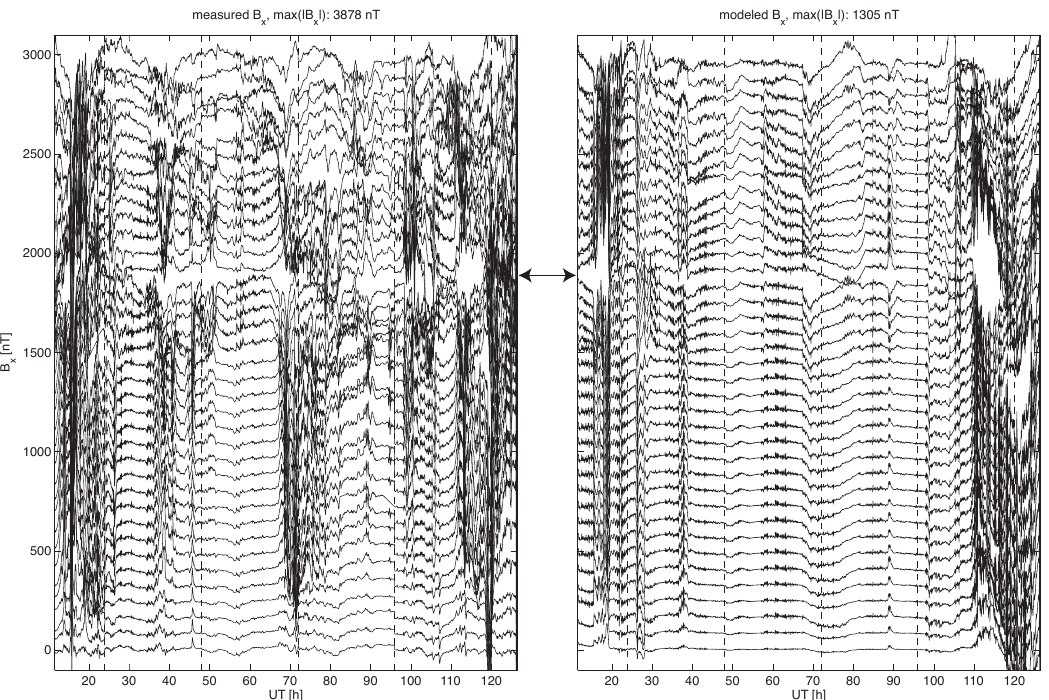
Fig. 4. The x-component (geographic north) of the measured (left panel) and the modeled (right panel) magnetic field fluctuations at stations shown in Fig. 3. Arrow in between the panels shows the separation between stations west of the Greenwich meridian (up from the arrow) and east of the Greenwich meridian (down from the arrow). Both sets are arranged from the geographically southernmost (bottom) to the northernmost (top) station. The time is UT hours from the beginning of 24 October 2003. The vertical dashed lines indicate the beginning of each new UT day.